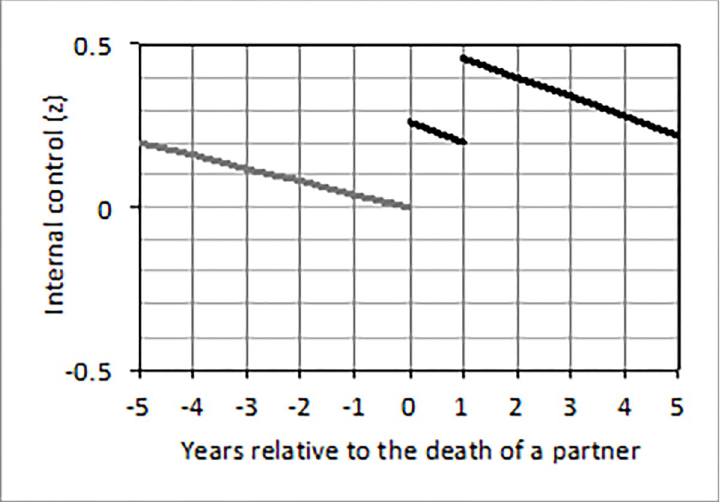
Fig 2. Changes of internal control beliefs from five years before until five years after the death of a partner in individuals who experienced this loss between 1991 and 1999 ( N = 437). Note . The first line indicates changes of perceived control in the five years before the death of a partner. It is based on the anticipation effect multiplied by the time (in years) until this loss. The second line indicates changes of perceived control in the first year after the death of a partner. It is based on the socialization effect multiplied by the time after this loss and the short-term effect. The third line indicates changes in perceived control more than one year after the death of a partner. It is based on the socialization effect multiplied by the time after this loss and the long-term effect. The second line and third line are marked in black because the short-term (second line) and long-term (third line) post-loss effect reached statistical significance ( p <